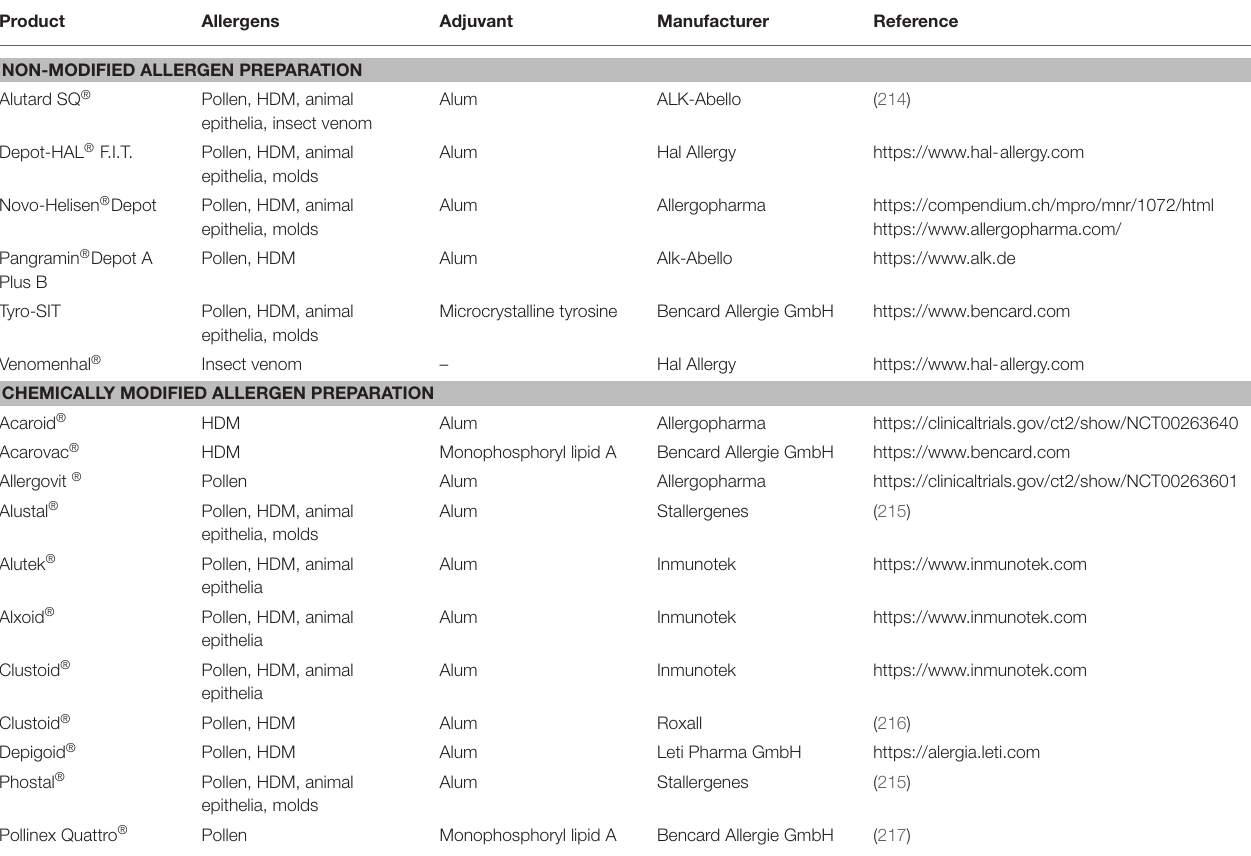
TABLE 1 | Overview on formulations in currently marketed SCIT vaccines in